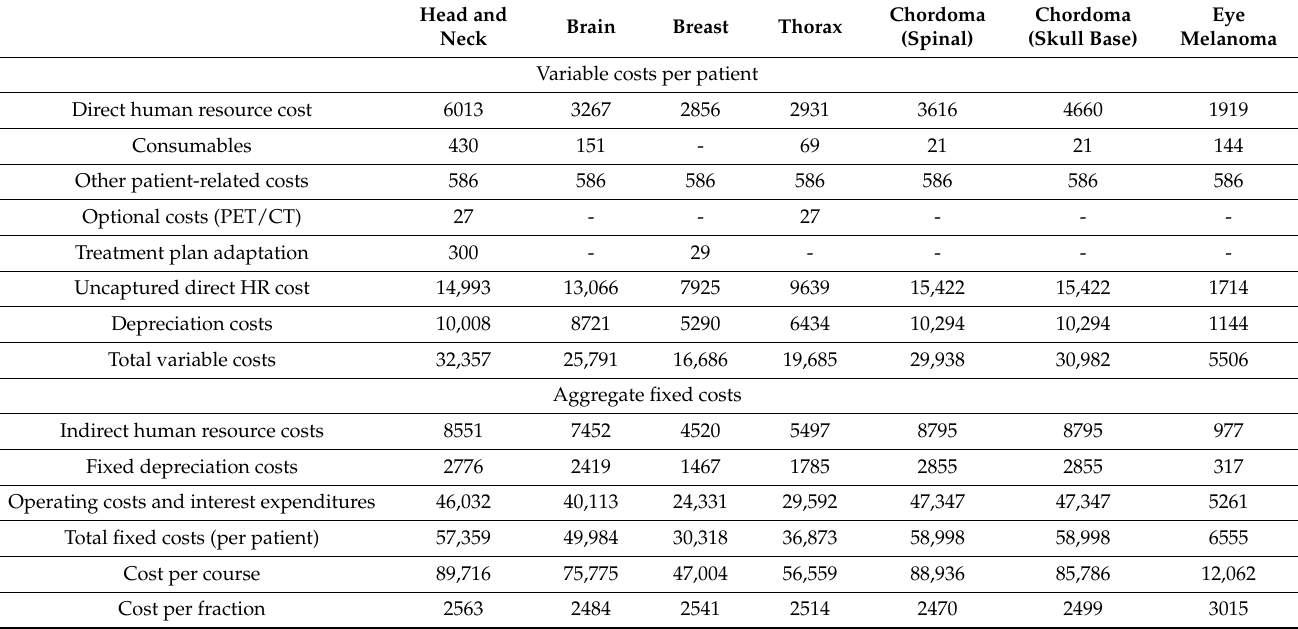
Table 2. Average total costs of PT per treatment indication (scheme 1) *.